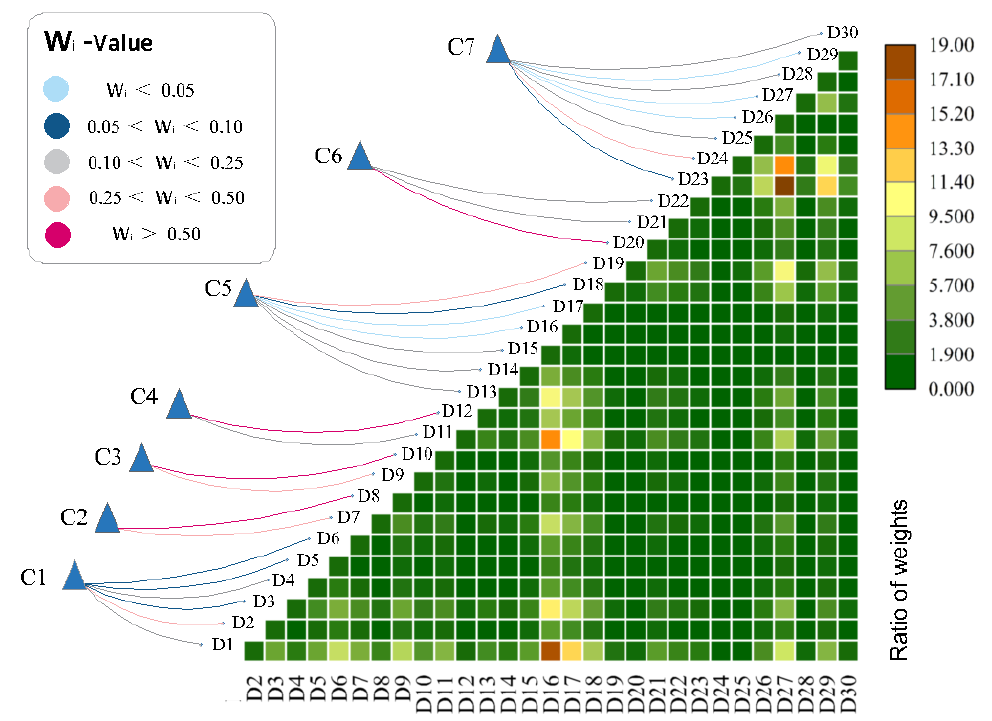
Figure 6. Weight ratio of all evaluation indices of the effective utilization coefficient of irrigation water. The weight ratio of each factor is plotted in Figure 6. The closer the color is to red, the more important the vertical indicator is relative to the indicator on the horizontal axis.